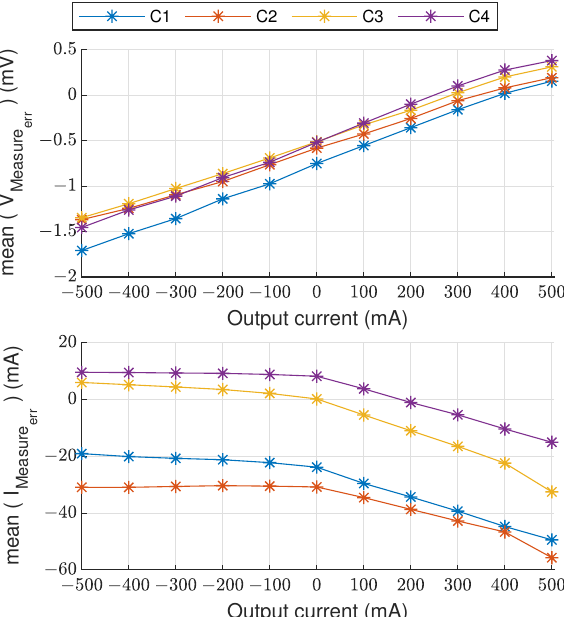
Figure 10. Mean voltage and current measurement errors as a function of the output current measured on the four samples of the cell emulator. Mean voltage error ( top ). Mean current error ( bottom